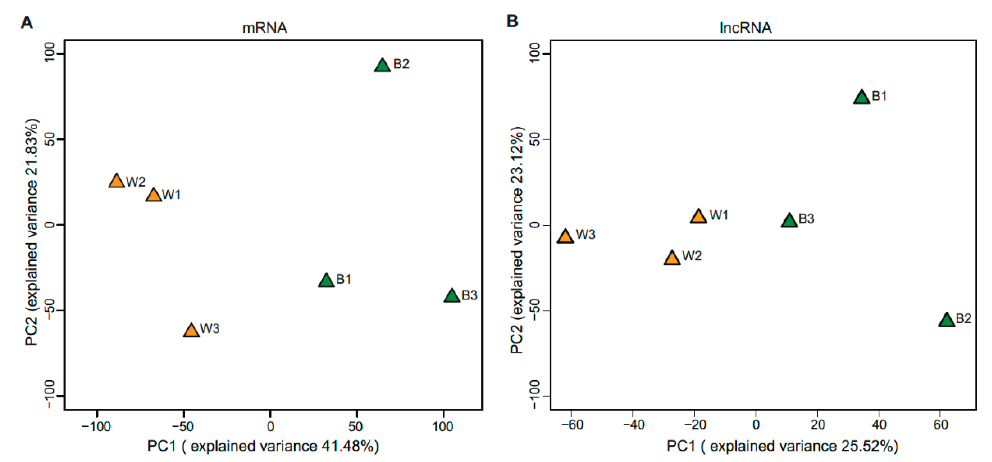
Table 1. Expression of the melanocyte-specific genes.